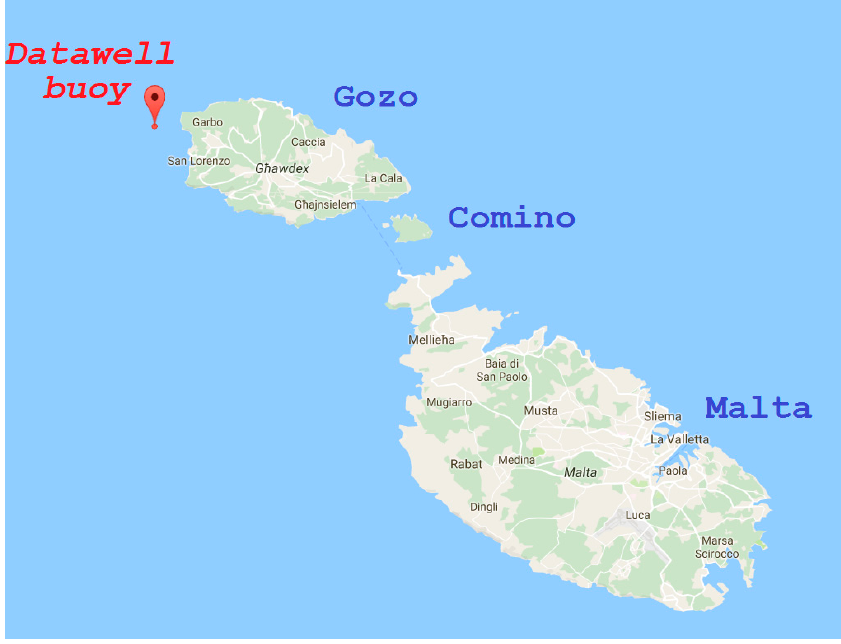
Figure 8. Position of the Datawell Waverider buoy along Maltese coasts.